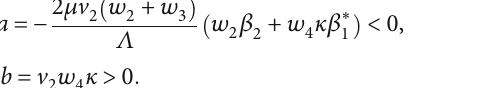
κ . D as a function of